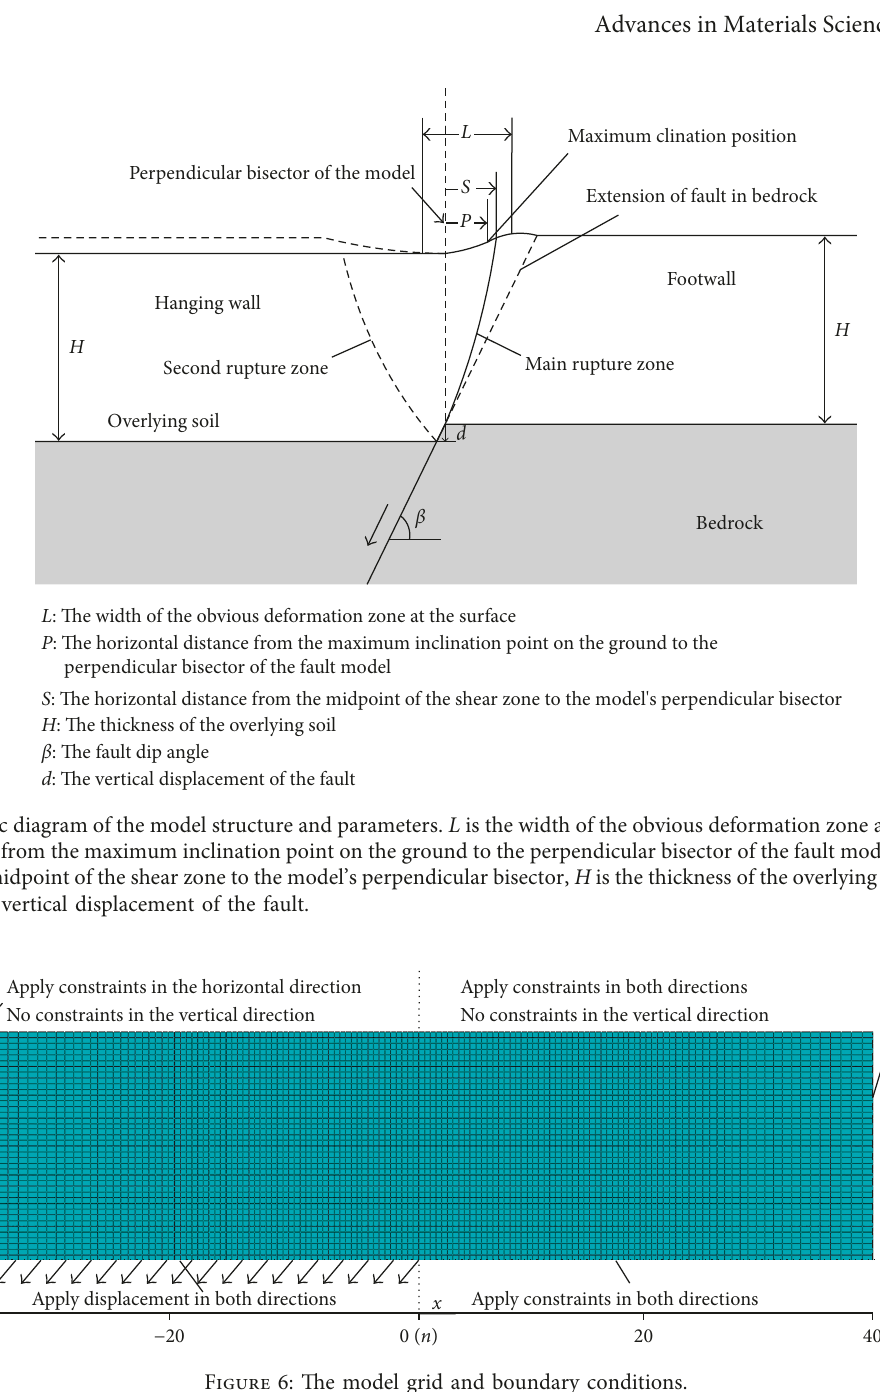
Figure 6: The model grid and boundary conditions.